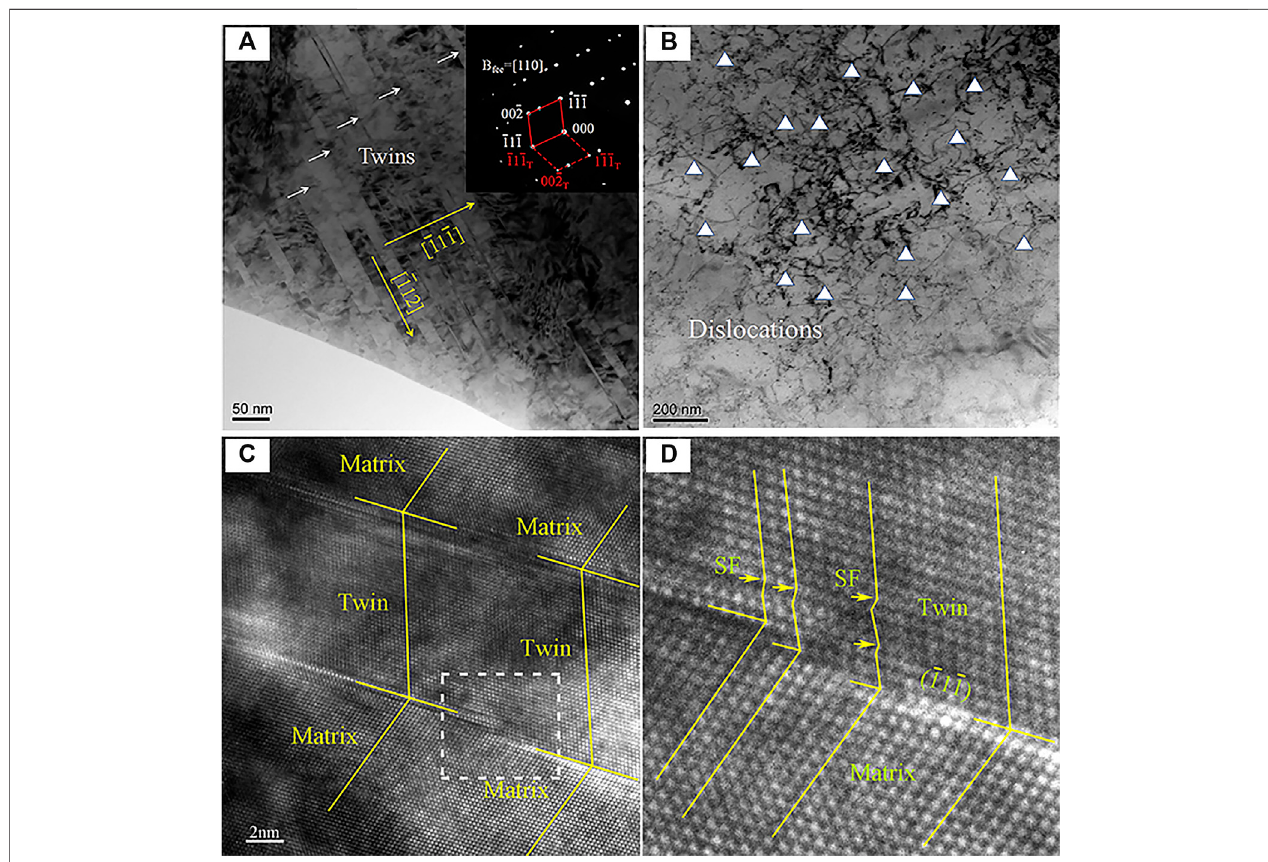
FIGURE9| Microstructure ofAl 0.3 CoCrFeNiHEAcompressivesamples (A) at600 ° C,showingparallelnano-twins, (B) at800 ° C,showinghighdensitydislocations (Zhangetal.,2018).HETEMimageofsamplecompressedat600 ° C, (C) atypical deformationtwin,and (D) theenlargedimageofthewhitedashedsquare(Zhangetal.,